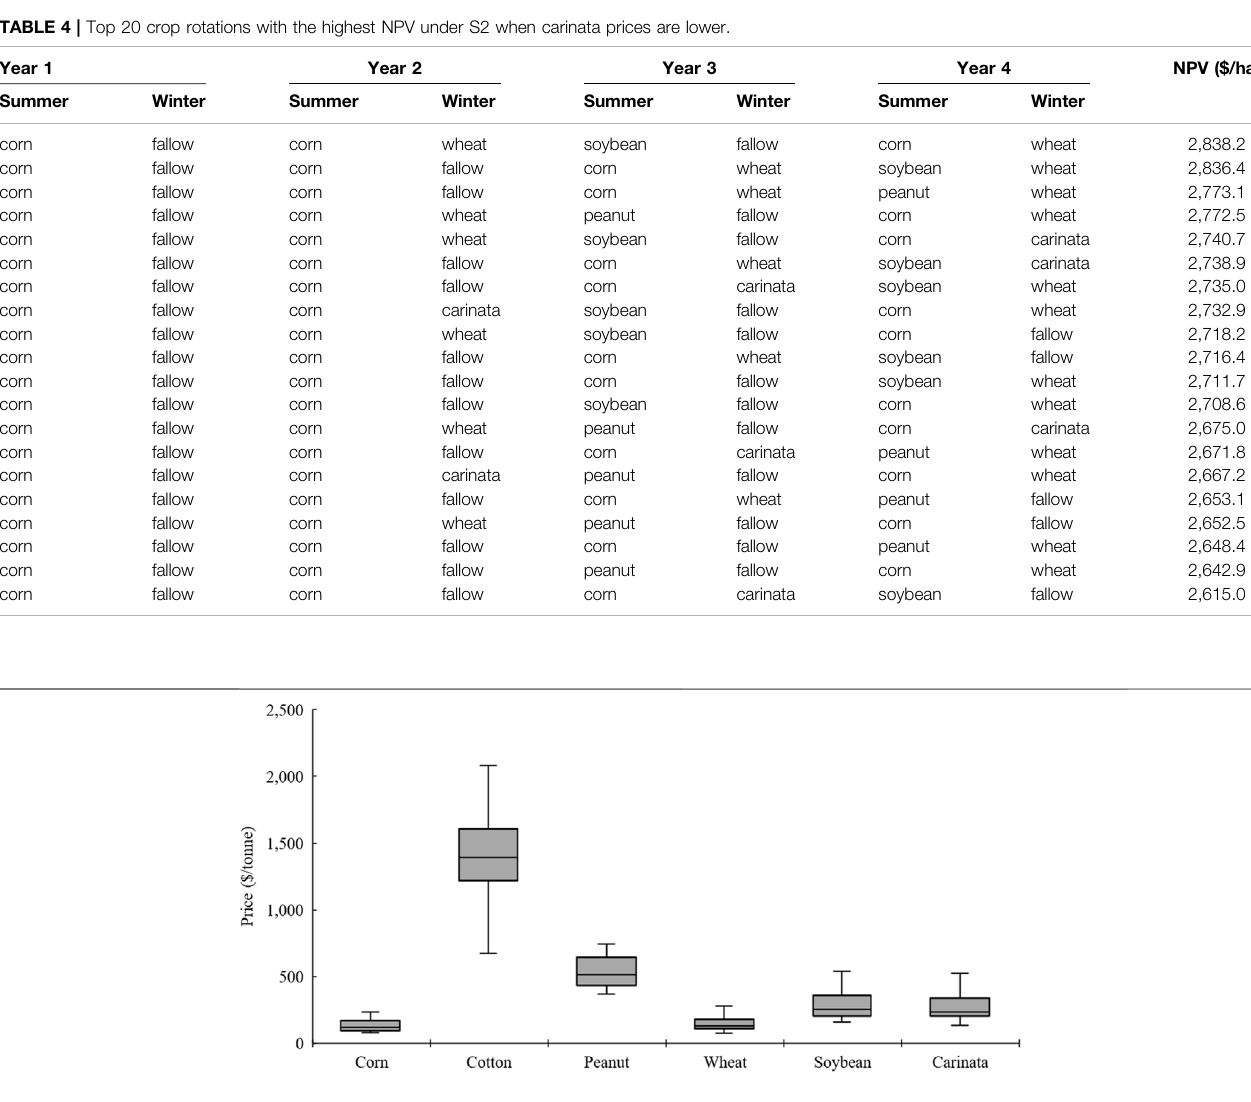
FIGURE 3 | Price variability for different crops in South Georgia between 1988 and 2019 (carinata under S1 and S2).